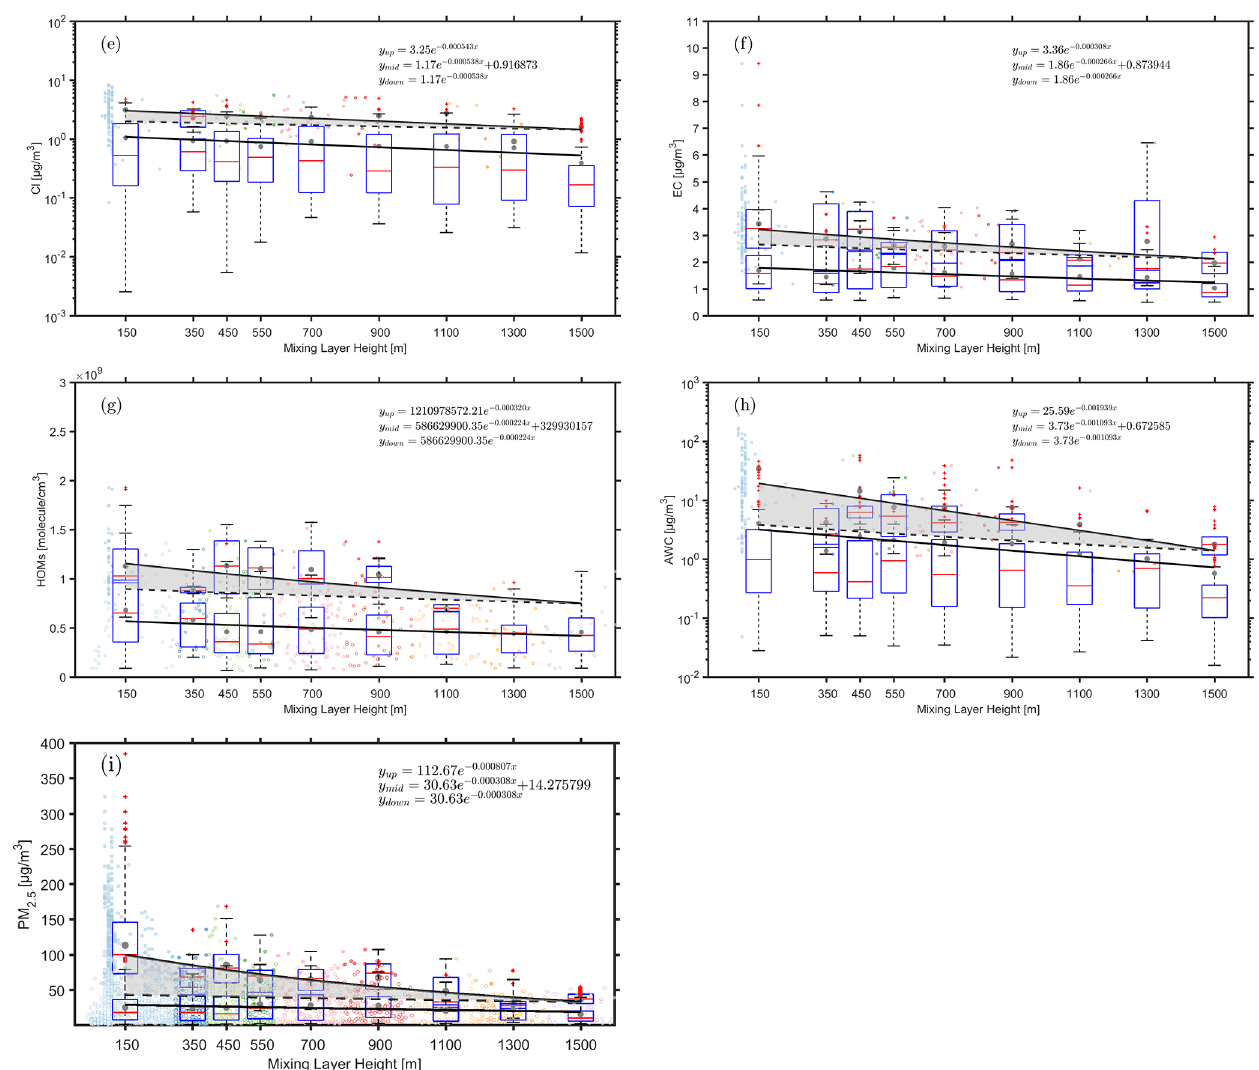
Figure 6. Observed dependency of organics (a) , nitrate (b) , ammonium (c) , sulfate (d) , chlorine (e) , element carbon (f) , HOMs (g) , AWC (h) and PM 2 . 5 (i) on the MLH during polluted and less-polluted conditions. The data related to the upper fitting line represent PM 2 . 5 concen- trations larger than 75µgm − 3 , while the data related to the lower fitting line represent PM 2 . 5 concentrations lower than 75µgm − 3 . Only daytime conditions determined by the ceilometer from non-rainy periods (RH < 95%) were considered. The solid cycles and hollow cycles denote concentrations that are more than 75µgm − 3 and less than 75µgm − 3 , respectively. The dark grey points and red lines in the boxes represent mean and median values, respectively. The shaded area between the upper solid and dotted lines corresponds to an increased amount of the specific compounds with decreased MLH, assuming that the compound has the same variation pattern under highly polluted conditions as in less polluted